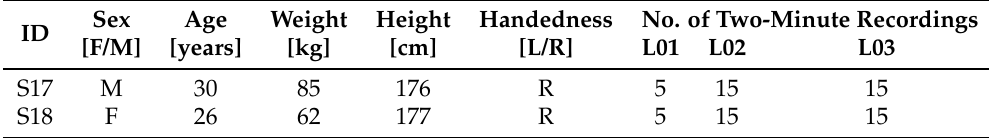
Table 1. Subjects—specifications and scenario assignment.